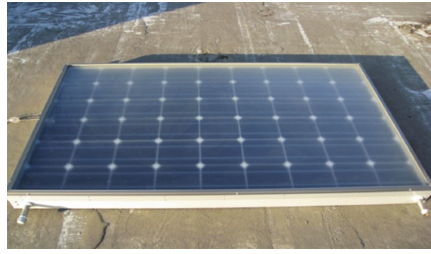
Figure 3: Glazed PVT